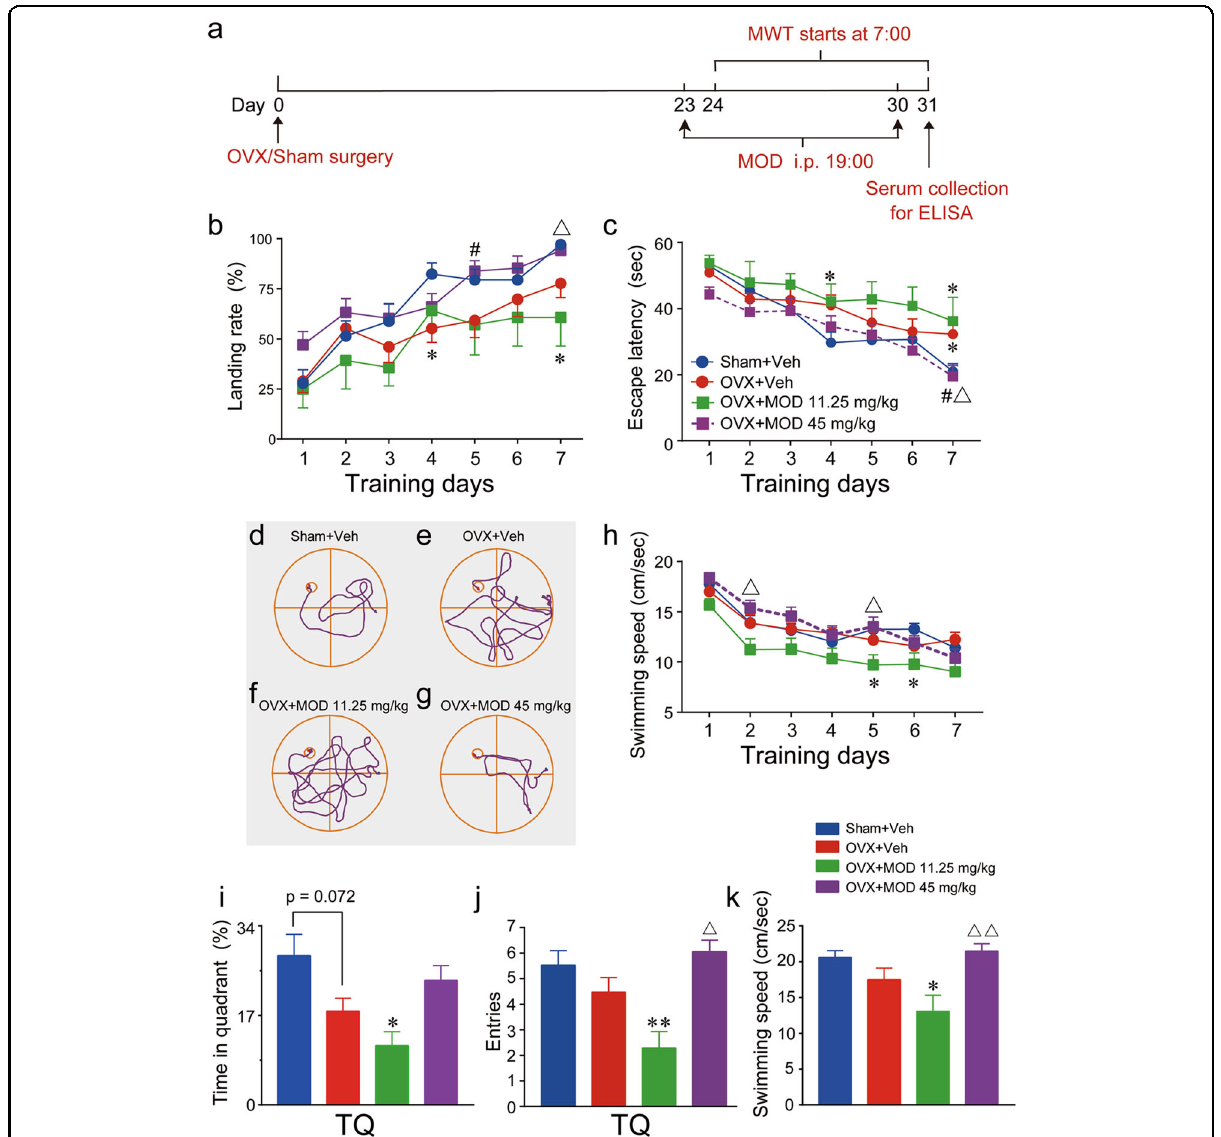
Fig. 2 Moda fi nil ameliorates ovariectomy-induced spatial memory de fi cits in the Morris water-maze test. a The Morris water-maze test (MWT) was conducted on the next morning after moda fi nil (MOD) was administered the night before. Serum was collected for estradiol evaluation using an enzyme-linked immunosorbent assay (ELISA). b The platform-landing rate, denoting the percentage of trials in which the submerged platform was found without guidance among the four trials for each mouse per day, of each group during the seven training days. c The average latencies of